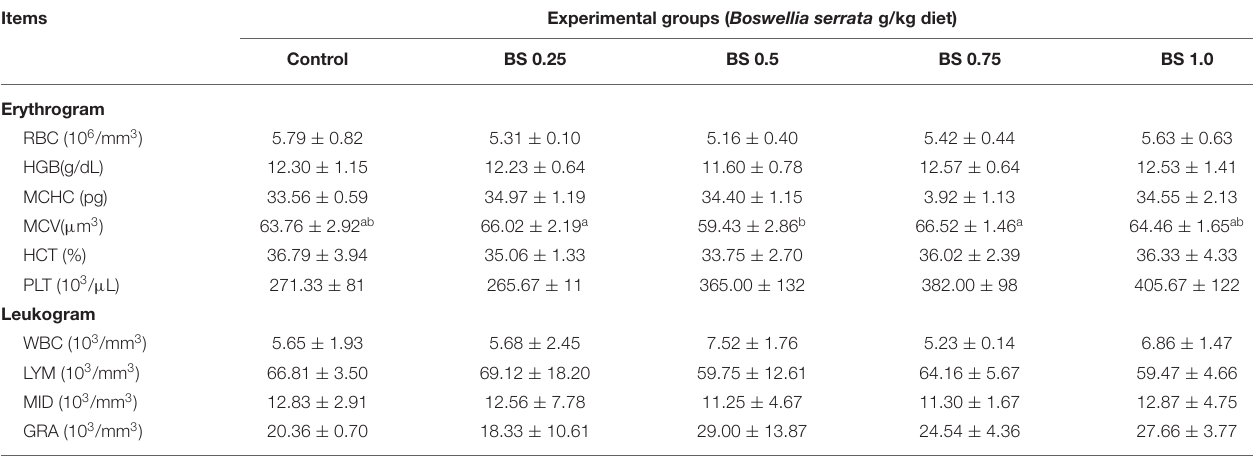
TABLE 4 | Blood parameters of growing NZW rabbits fed different levels of Boswellia Sarrata in diet at 12 weeks of age.